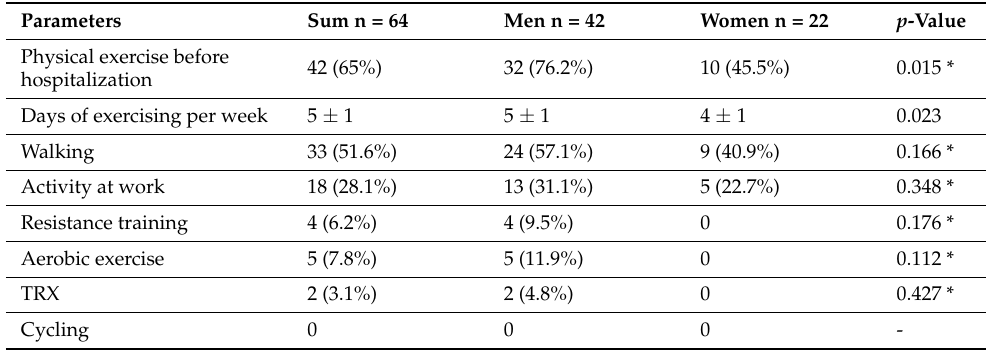
Table 4. Physical activity of the study’s population before hospitalization and comparisons based on sex, n =